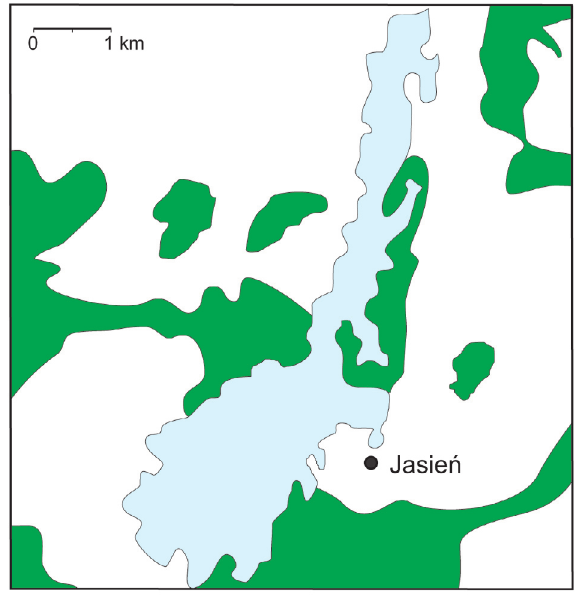
Fig. 4. Forest areas distinguished according to the map by Gilly